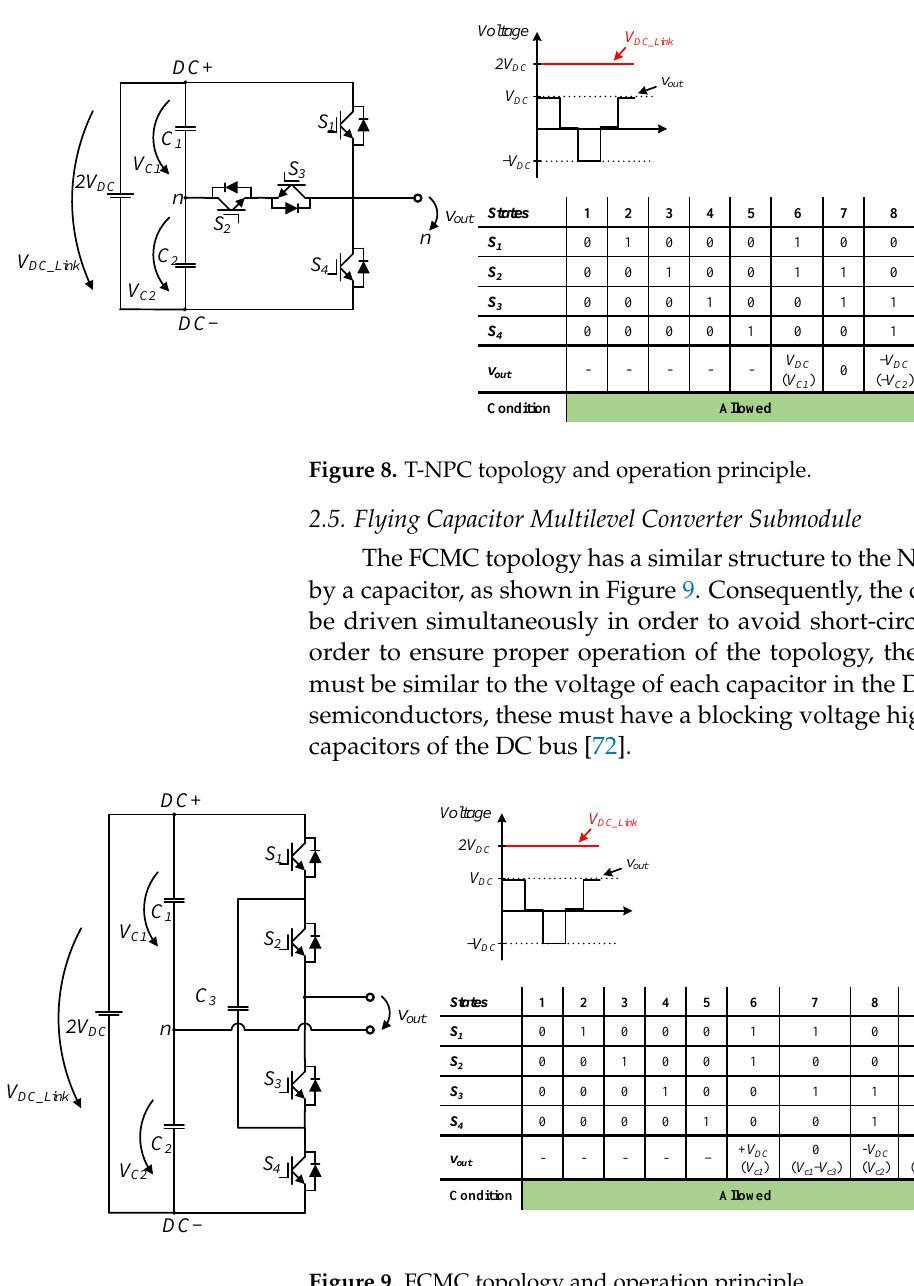
Figure 9. FCMC topology and operation principle.